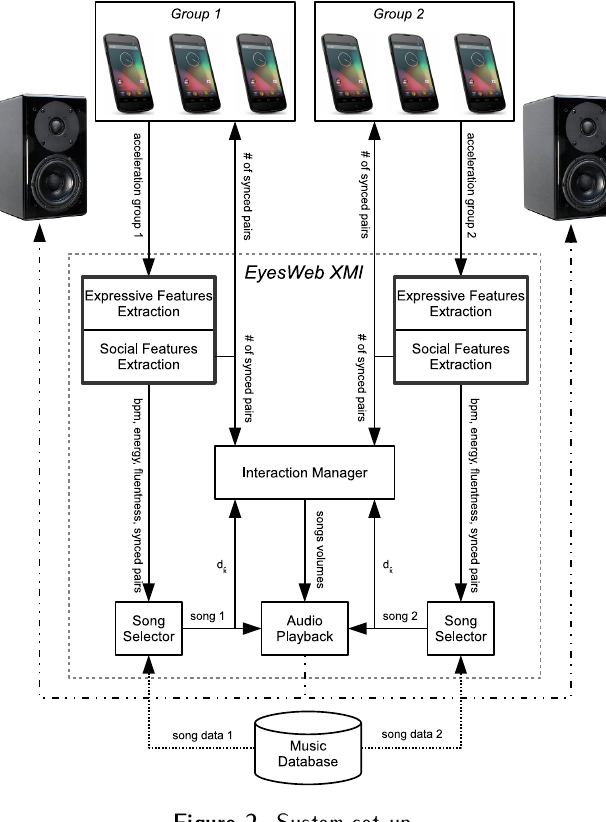
Figure 2. System